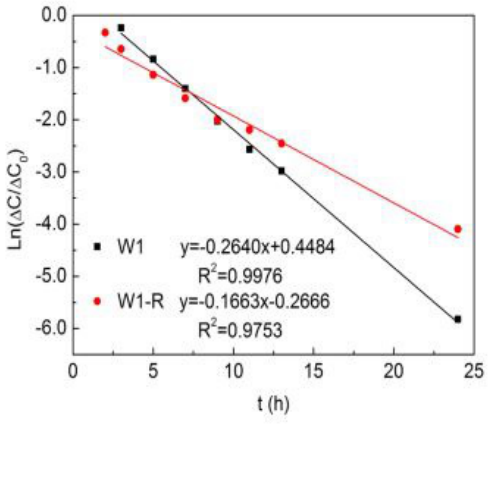
Fig. 1 Ln( ∆ C/ ∆ C 0 ) vs